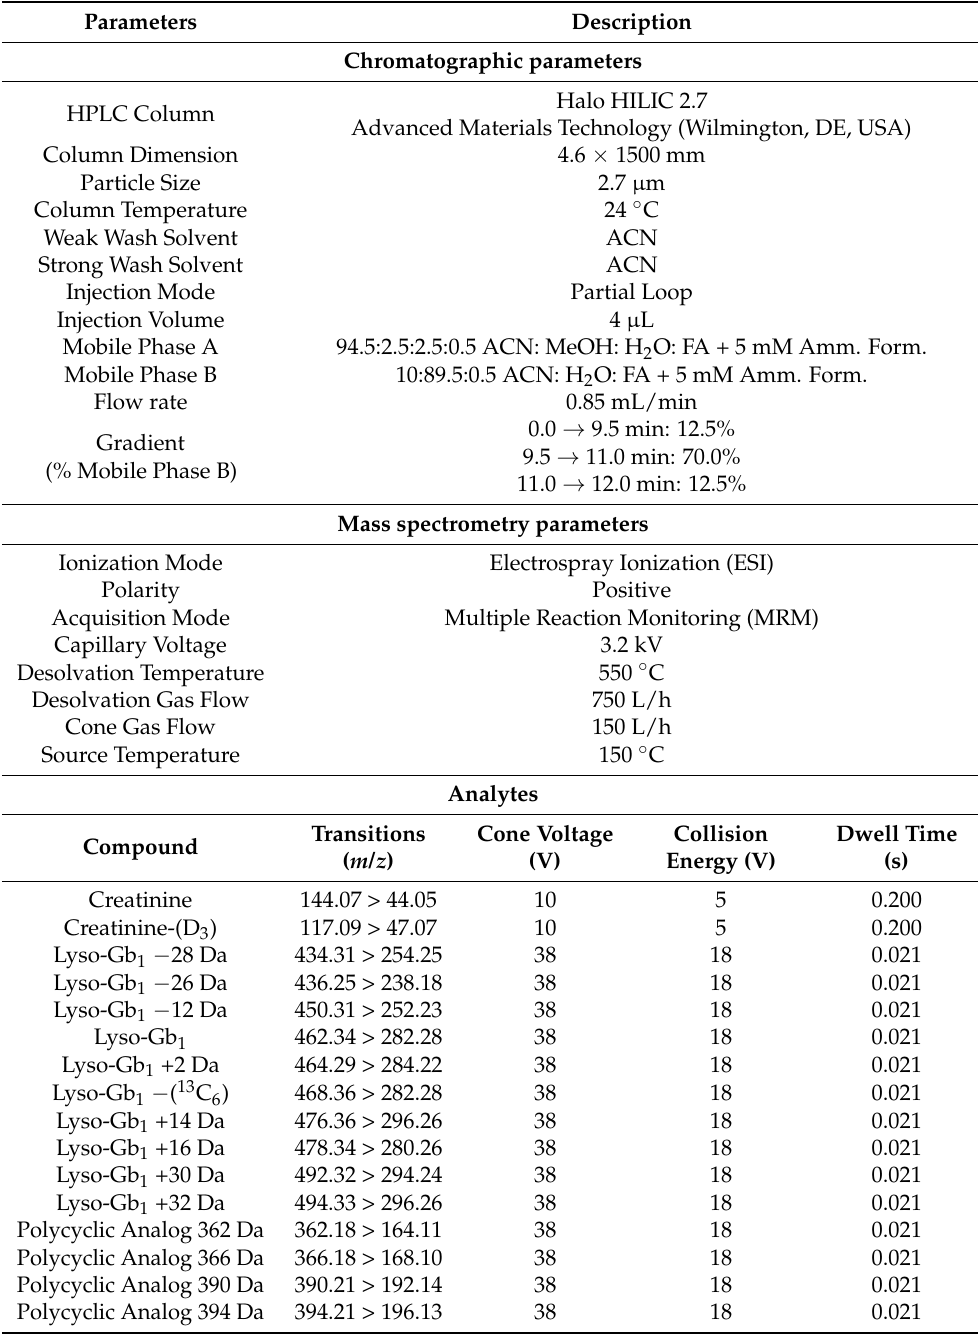
Table 1. Ultra-performance liquid chromatography coupled to tandem mass spectrometry (UPLC- MS/MS) method